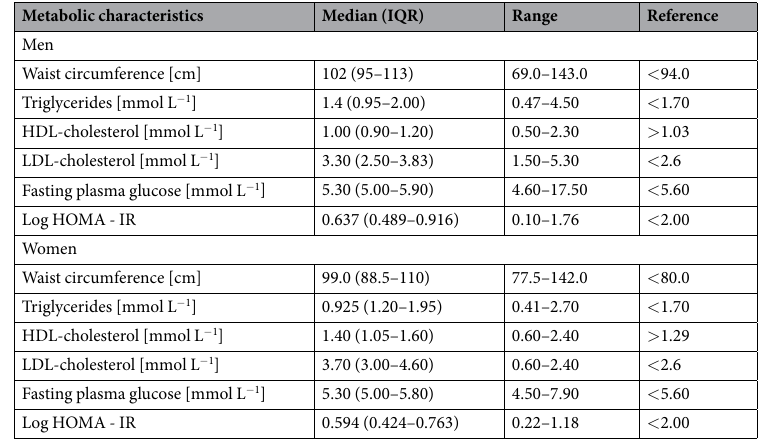
Table 2. Metabolic characteristics of the psychosis patients (n = 120). IQR: interquartile range. HDL: high- density-lipoprotein. LDL: low-density-lipoprotein. Log HOMA-IR: log 10 of homeostatic model of assessment for insulin